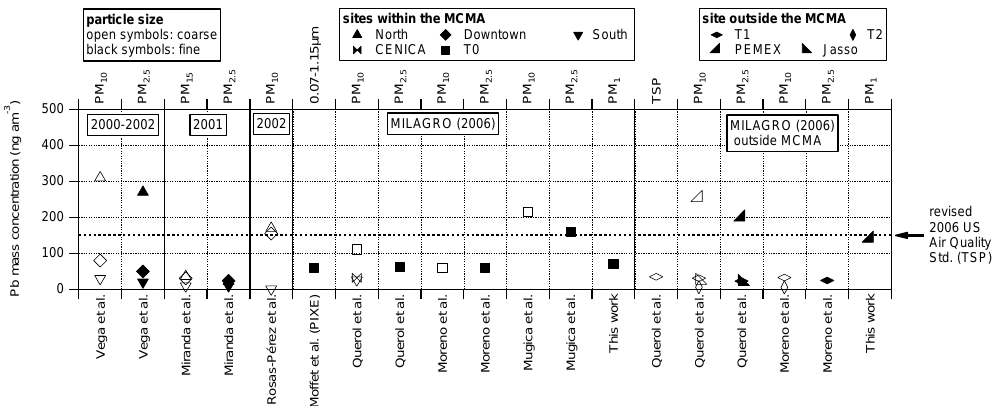
Fig. 1. Summary of particle Pb measurements within the MCMA since 1997. Boxes on top of the measurements indicate the year in which the samples were collected. North, Downtown and South sites indicate general areas within the MCMA. The approximate location of the sites is marked in Fig. S1. The concentrations for previous publications are assumed to be reported under ambient (and not STP) conditions as this is more common for ground-based studies, although none of the previous papers specifies which convention is